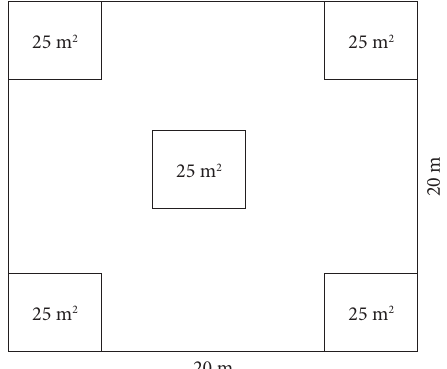
Figure 3: Layout of the main plot and subplot